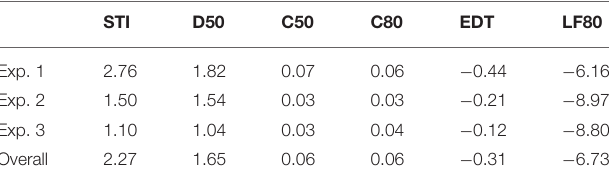
TABLE 3 | Values of β in Equation (1) for different room acoustical parameters in the three experiments (all p < 0.01). STI D50 C50